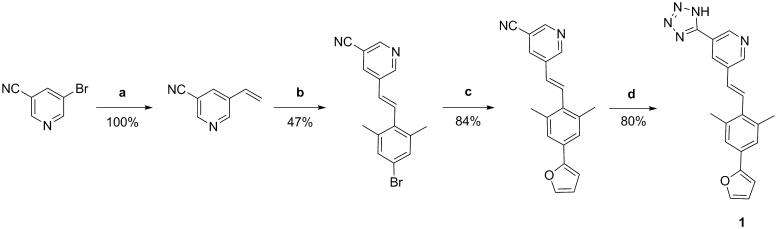
Reaction scheme for synthesis of compound 1. Reagents and conditions: (a) tributylvinyl tin, LiCl, Pd(PPh3)2Cl2, DMF, 70 °C; (b) 5-bromo-2-iodo-1,3-dimethylbenzene, Pd2dba3, triethylamine, P(o-tol)3, DMF, 95 °C; (c) furan2-ylboronic acid, K2CO3, Pd(PPh3)4, water, THF, 100 °C; (d) NH4Cl, NaN3, anhydrous DMF, 110 °C.